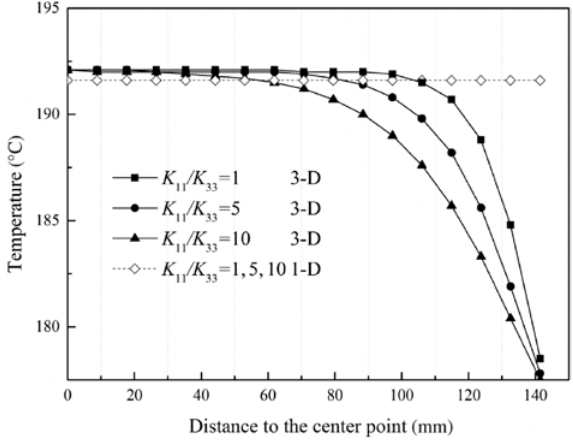
Figure 10: Temperature of laminates with different K